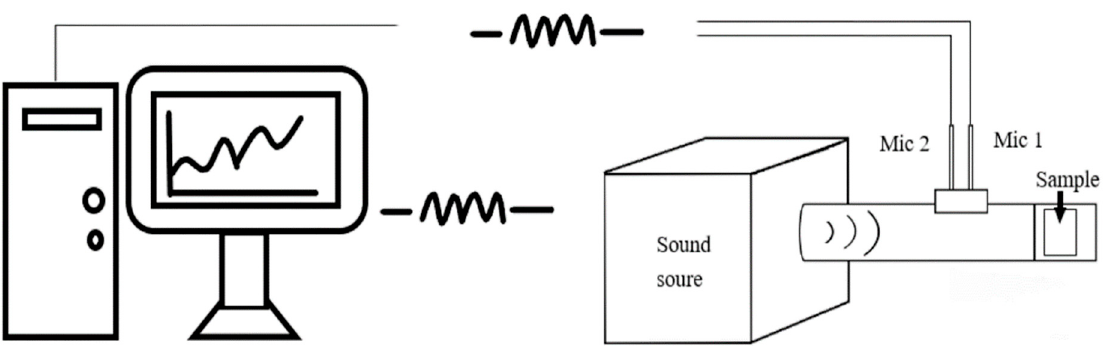
Figure 2. Diagram of two microphones method for sound absorption coefficient measurement.